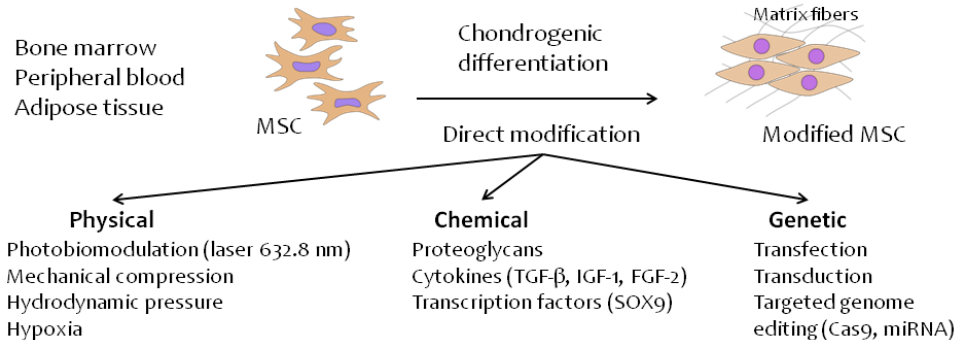
Figure 1. Direct methods of MSC modification for chondrogenic differentiation in hyaline cartilage tissue.